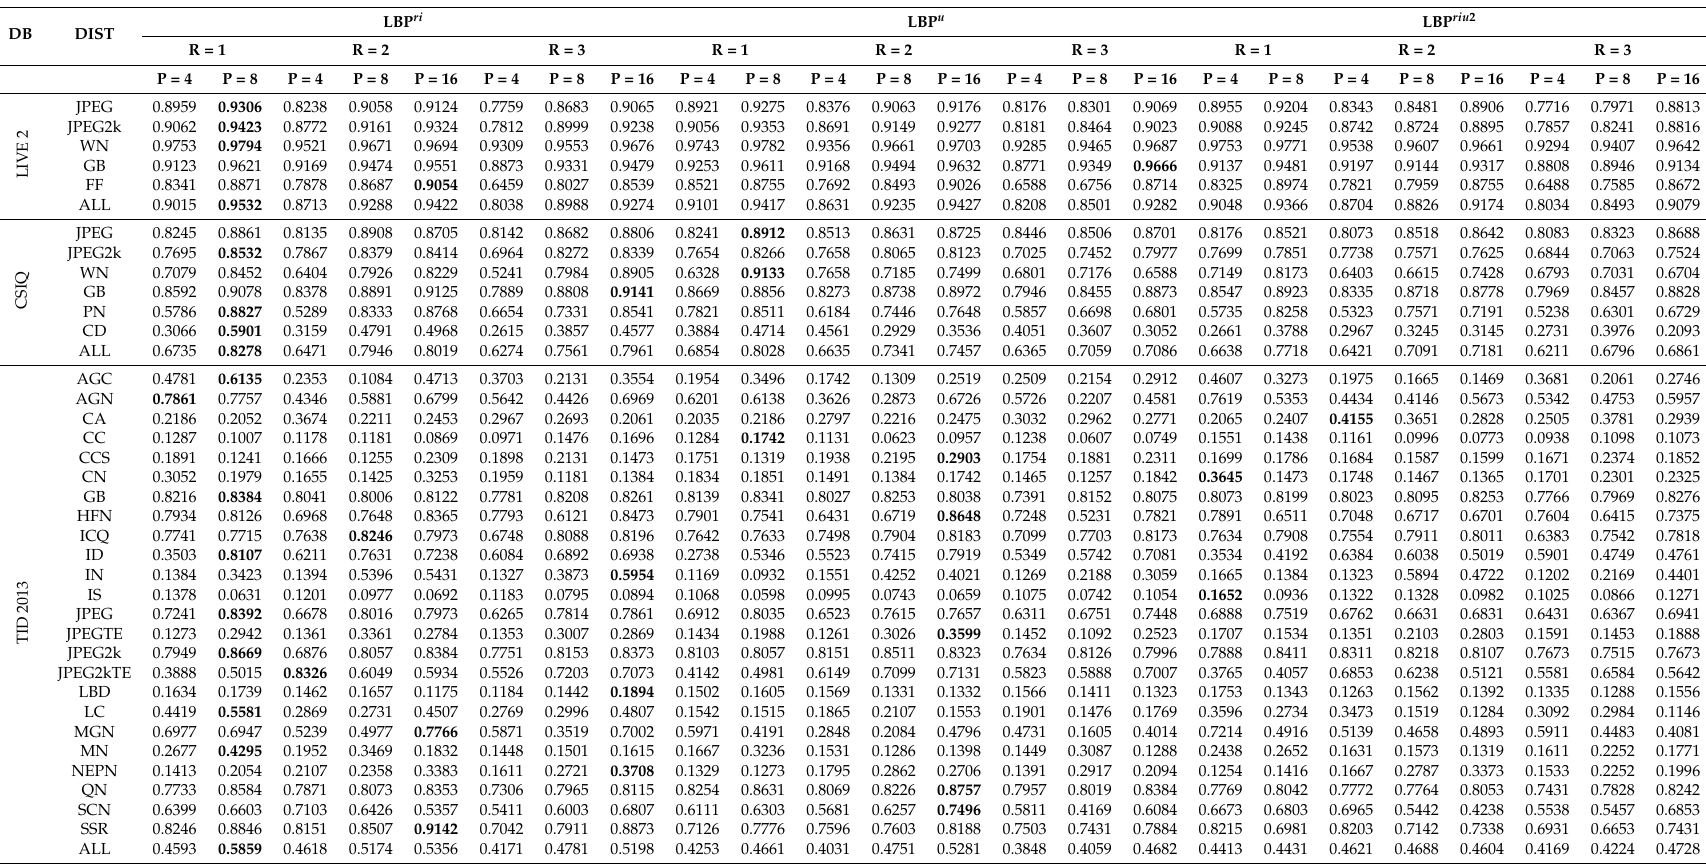
Table 2. Average SROCC of simulations on tested image databases using basic LBP